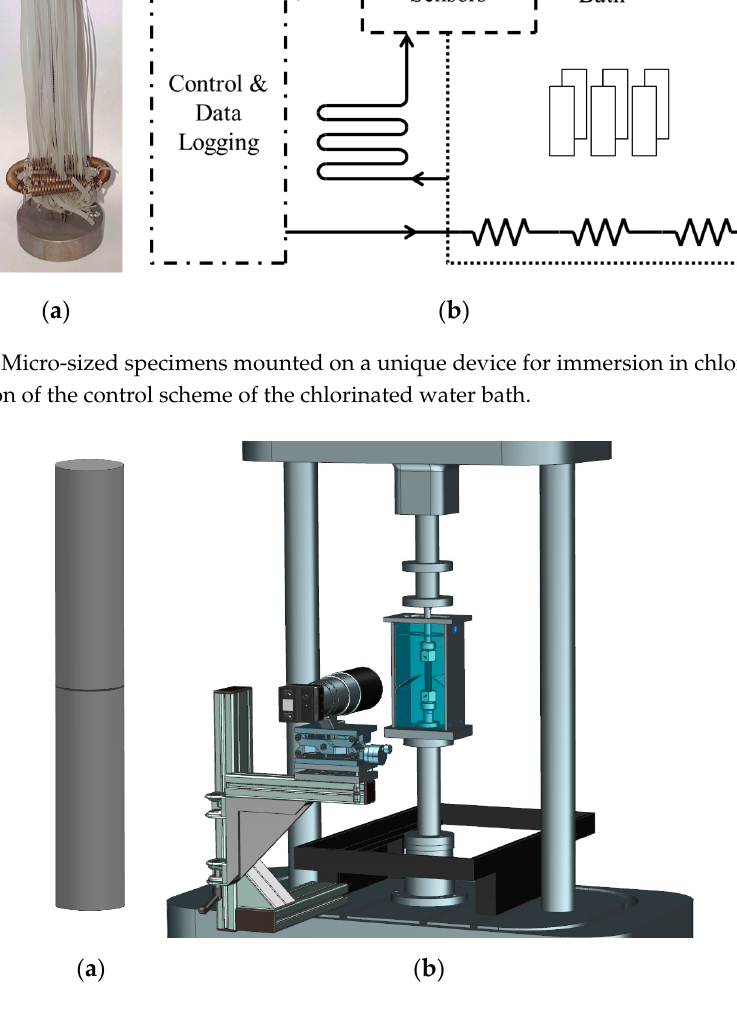
Figure 2. ( a ) Schematic illustration of a cracked round bar (CRB) specimen; ( b ) CRB specimen mounted on a tension-torsion electro-dynamic testing machine equipped with an environmental containment and an optical crack length measurement